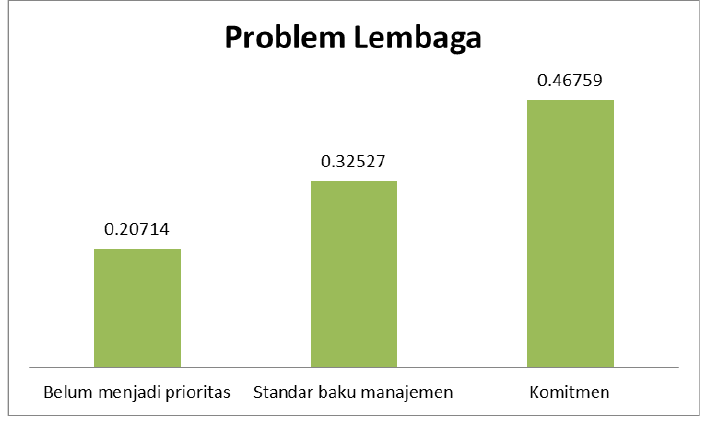
Diagram 2. Problem Lembaga (Internal)